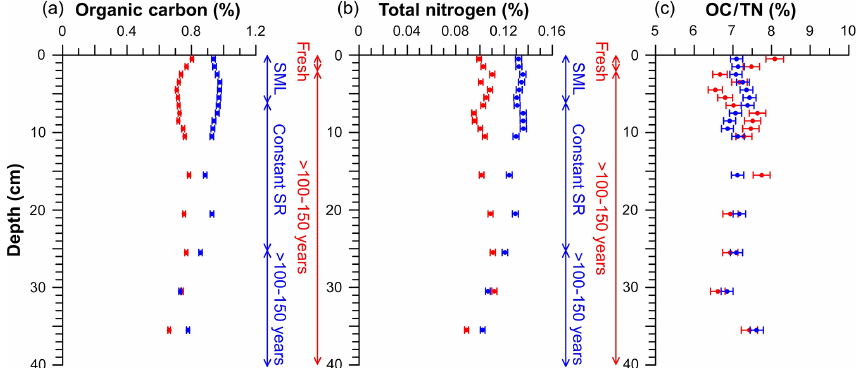
Figure 4. Profiles from elemental analyses of untrawled (blue) and trawled (red) cores. Organic carbon (a) , total nitrogen (b) , and the OC / TN ratio (c) . The analytical error is represented by error bars. Vertical scales indicate the process that has occurred in the depth range given for both untrawled (blue) and trawled (red) sediment cores. SML: surface mixed layer; SR: sedimentation rate.